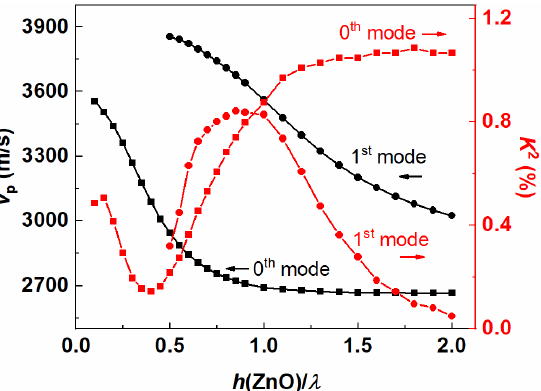
Figure 7. v p and K 2 of Rayleigh-mode waves as functions of h (ZnO) in the SAW devices based on the c-ZnO/c-GaN structure.